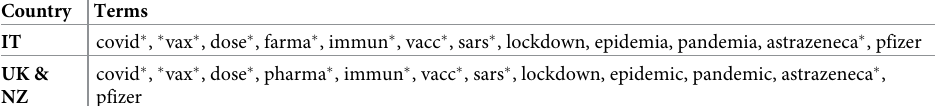
Table 1. List of terms employed in the data collection of posts on Facebook. The asterisk represents a general string appearing before or after the term, depending on its position. Country